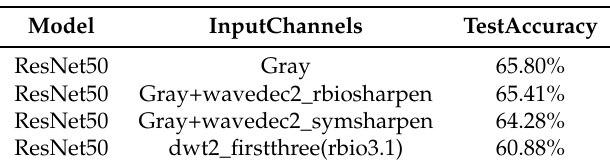
Table 5. The results of the RAF Compound test set based on different input channels of ResNet 50 pretrained on FER2013 and RAF